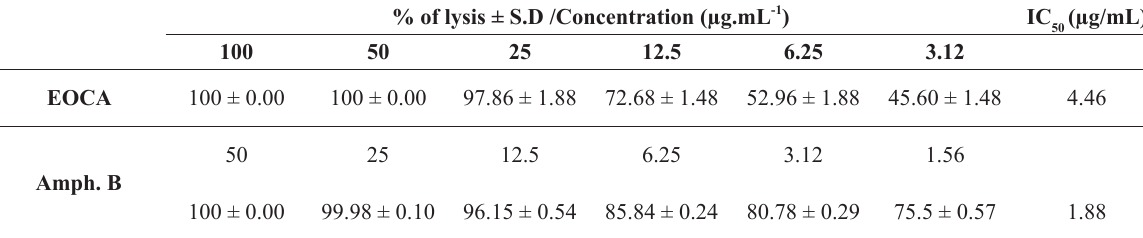
Leishmanicidal activity of the leaf essential oil of C. aschersoniana against L. amazonensis promastigote